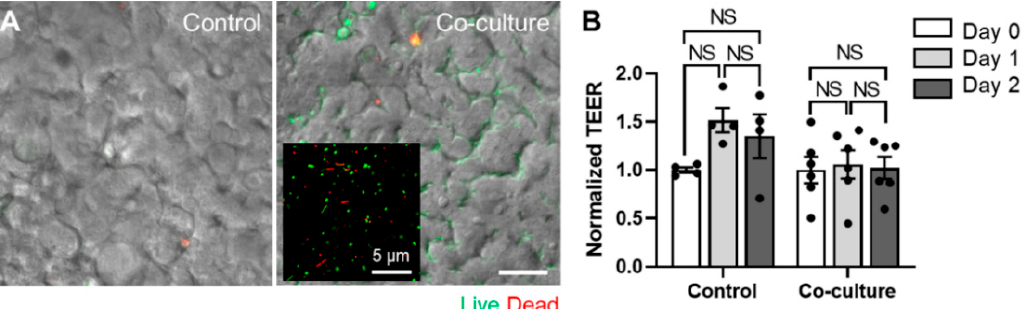
Figure 6. The co-culture of the fecal microbiome in a PMI Chip lined by 3D intestinal epithelium under an AOI. ( A ) The overlaid images of a DIC and a fluorescent micrograph show the snapshot of a host– microbiome co-culture in the PMI Chip. The human fecal microbiome (initial seeding density, 5 × 10 4 cells/mL) was co-cultured with the germ-free Caco-2 intestinal epithelium in a PMI Chip under luminal flow (100 µL/h) and multiaxial stretching motions (5% in cell strain, 0.15 Hz in frequency)